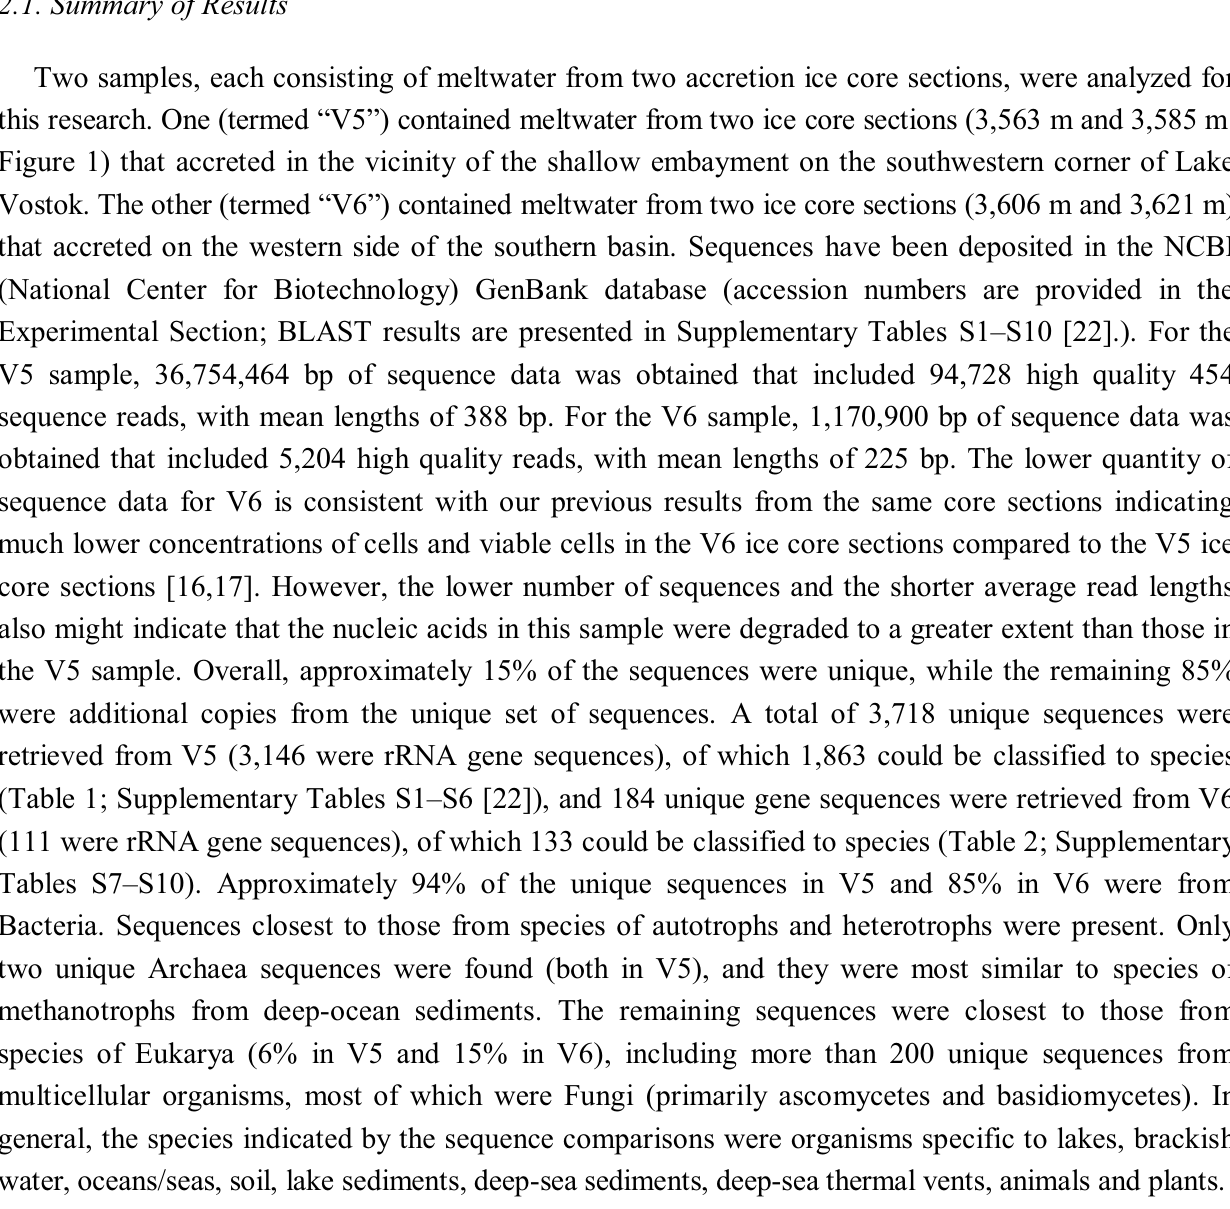
Table 2. Summary of sequence results for V6 (total of 133 classified taxonomically;